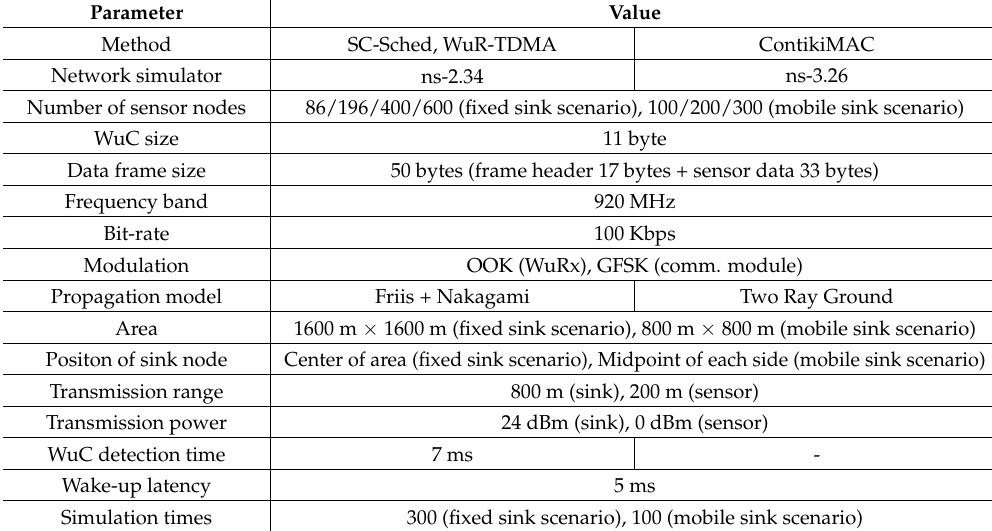
Table 2. Simulation parameters.